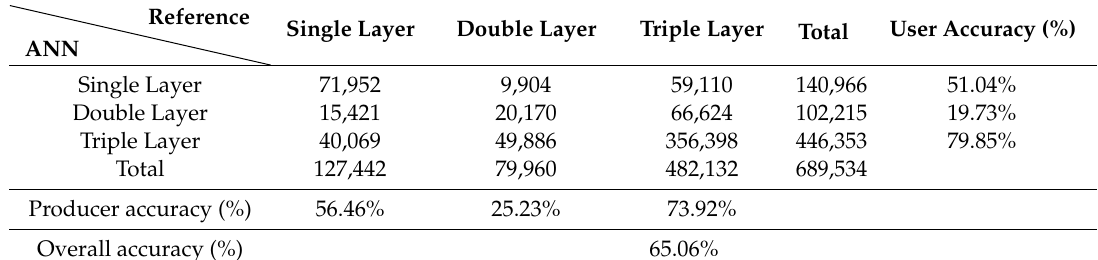
Table 3. Validation of forest vertical structure classified by using the ANN (unit: